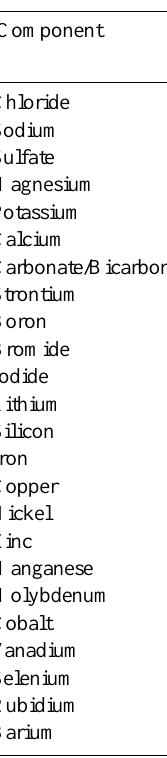
Table 1. Concentration of components in synthetic seawater made from ”Marine Salt” purchased from manufacturer (Seachem) and diluted into MilliQ water as per manufacturer recommendations. The synthetic seawater formed the basis for frozen halide